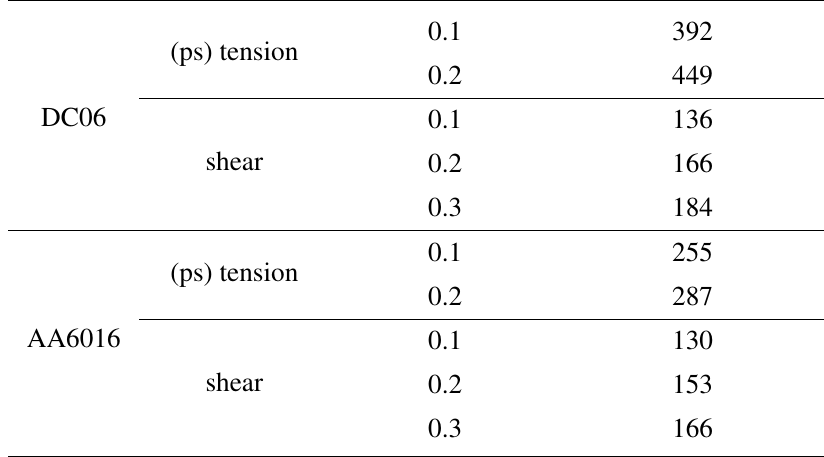
Table 3. Relative deformation states of the TEM-samples in (true) stress-strain space (normal strain ε to normal Cauchy stress σ , resp. shear strain γ to shear Cauchy stress τ ). ps, plane